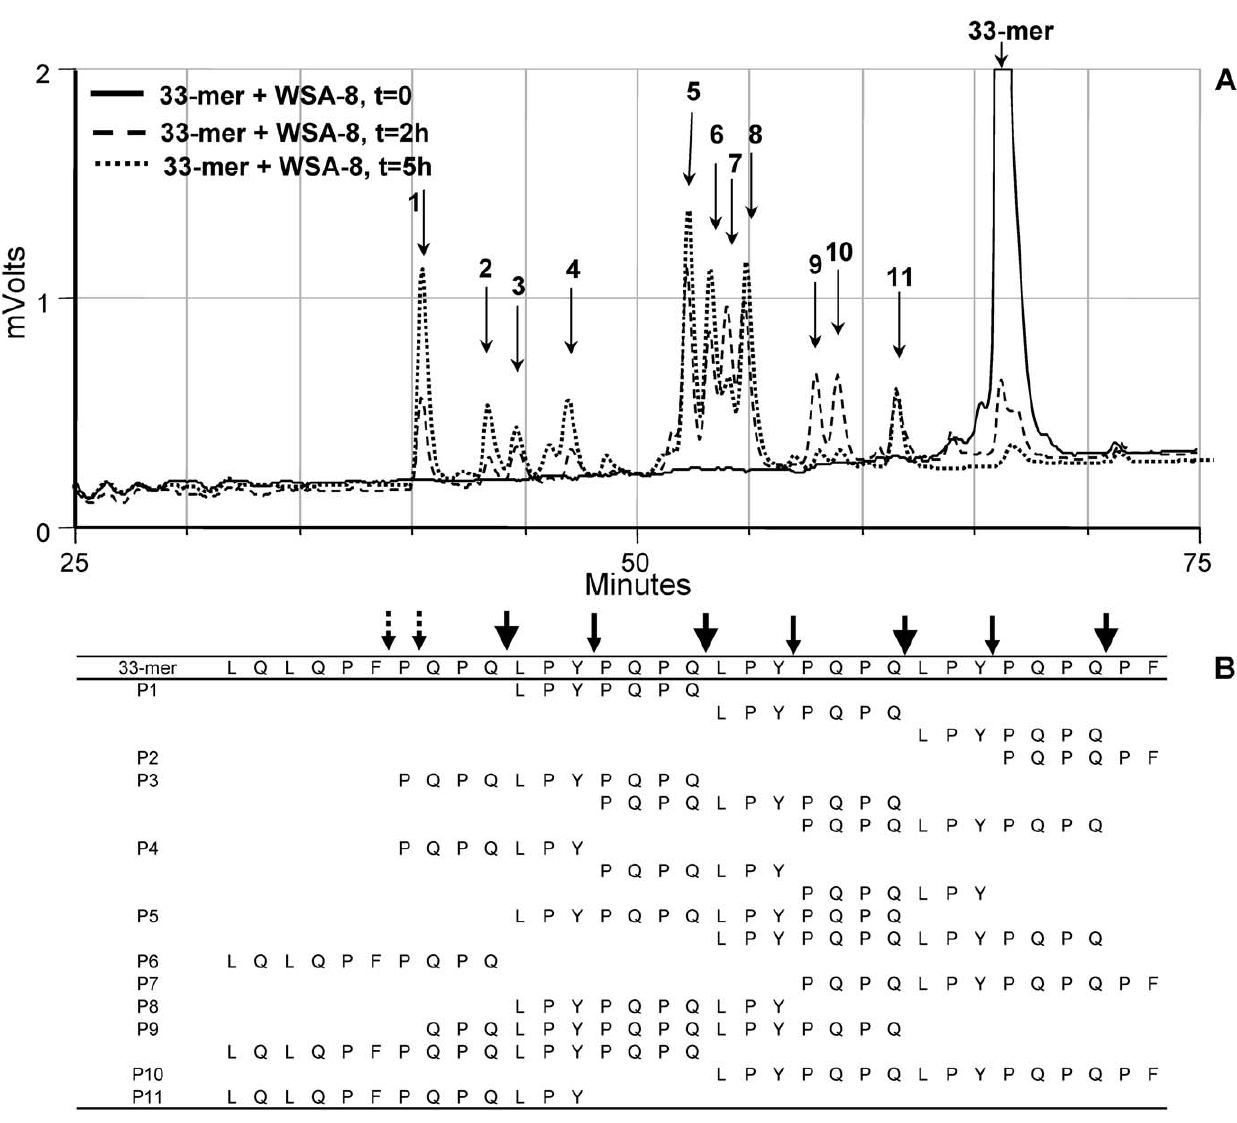
Figure 5. Degradation and fragment analysis of the 33-mer incubated with R.aeria . Gliadin 33-mer (250 m g/ml) was incubated in a suspension of WSA-8 ( R. aeria ) cells (OD 620 1.2). Incubation aliquots removed after 0 h, 2 h and 5 h were analyzed by RP-HPLC (A). Degradation peaks labeled 1 to 11 were collected and sequenced by LC-ESI-MS/MS (B). Large arrows: cleavage after QPQ; small solid arrows: cleavage after LPY; small dotted arrows: other